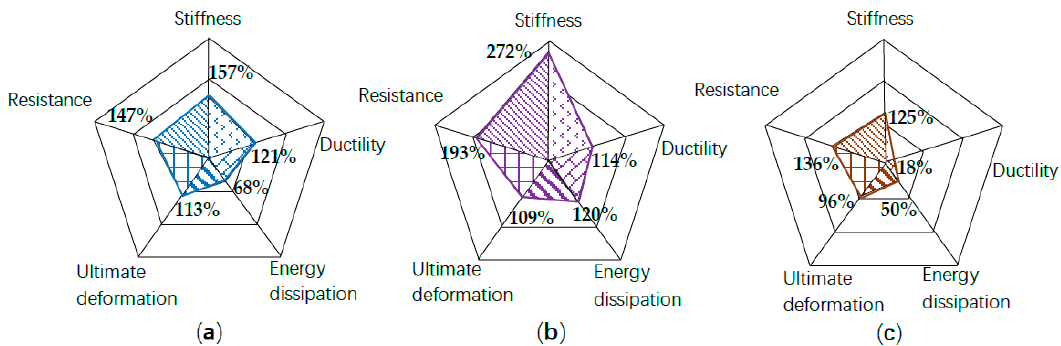
Figure 12. Percentage of performance rehabilitation and improvement of the strengthened walls comparing to the unstrengthened W1: ( a ) W1S; ( b ) W2; ( c ) W3.